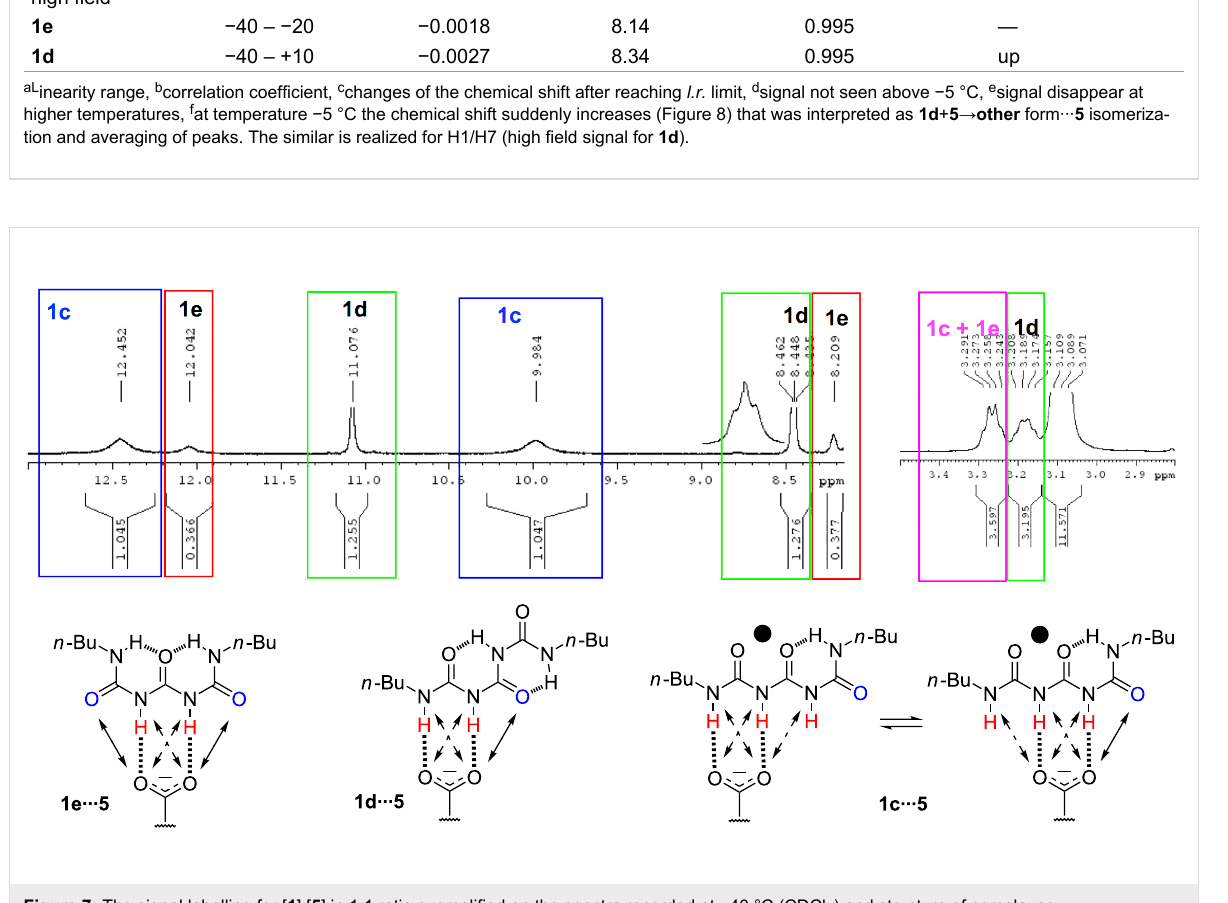
shape (broadened singlet tending to triplet shape), while H3/H5 signals shift from 9.13 ( 1 ) to 12.04 ppm due to interaction with an anion. The broadest NH signals come from 1c ∙∙∙ 5 complex that, most probably, exist in a fast equilibrium as shown in Figure 7. In the aliphatic part of the spectrum, except the meth- ylene of + N( n- Bu) 4 cation (at 3.09 ppm, out of the green box, Figure 7), two characteristic signals are visible. It is worth pointing out that their assignment based on integration is in perfect agreement with the data obtained by integration of NH protons in the same spectrum. The ratio of 3.597/3.195 = 1.126 while the respective sum of NH (H3/H5) integration in 1c and integration of NH in 1e divided by integration of NH in 1d (H3/H5) is 1.411/1.255 = 1.124. Figure 8 shows a rapid